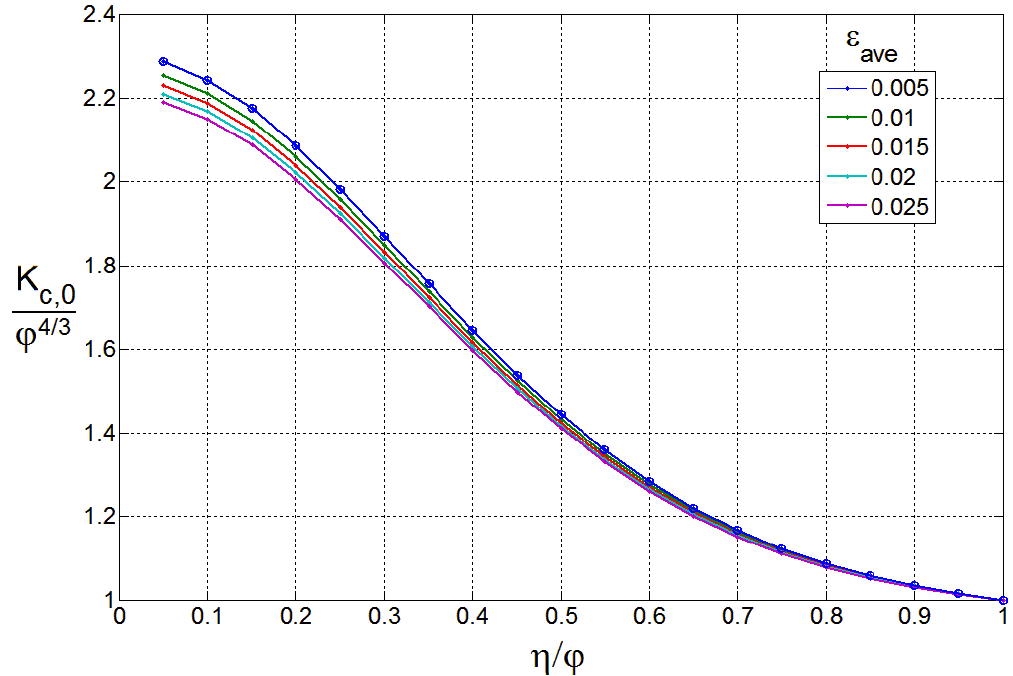
Figure A3. Stress concentration under no tension and for various distortion velocity ratios and average strain values. Initially η is small, and ϕ is fairly close to one in